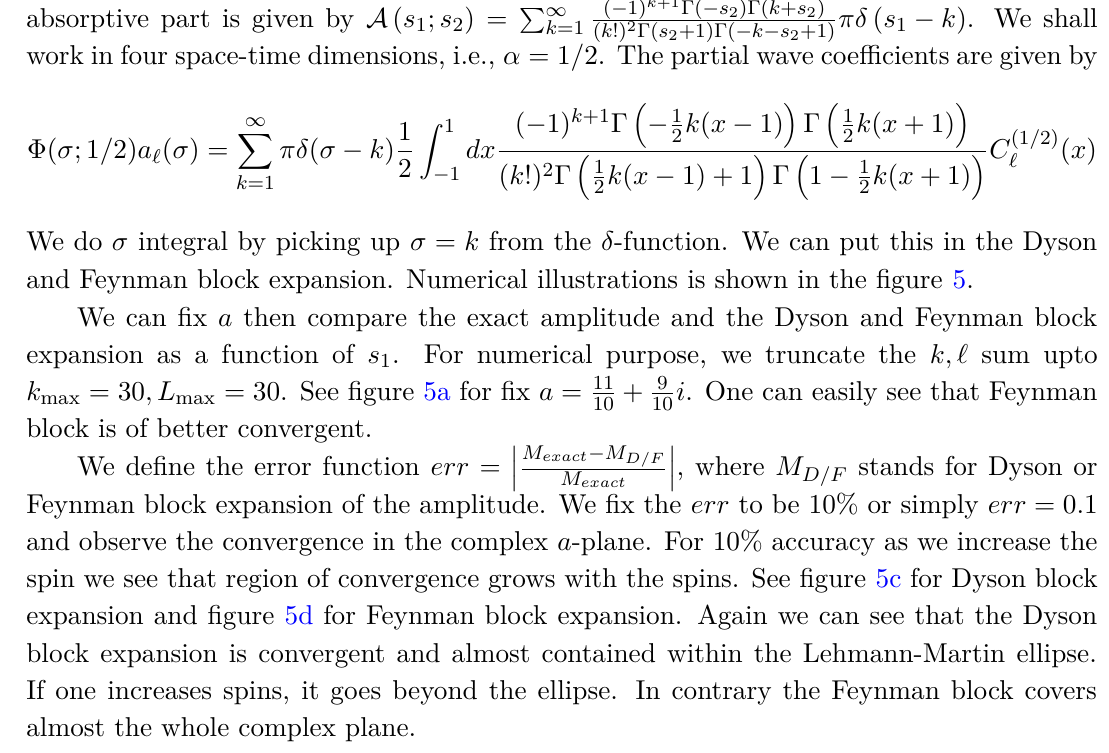
πδ ( s − k ) . We shall 1